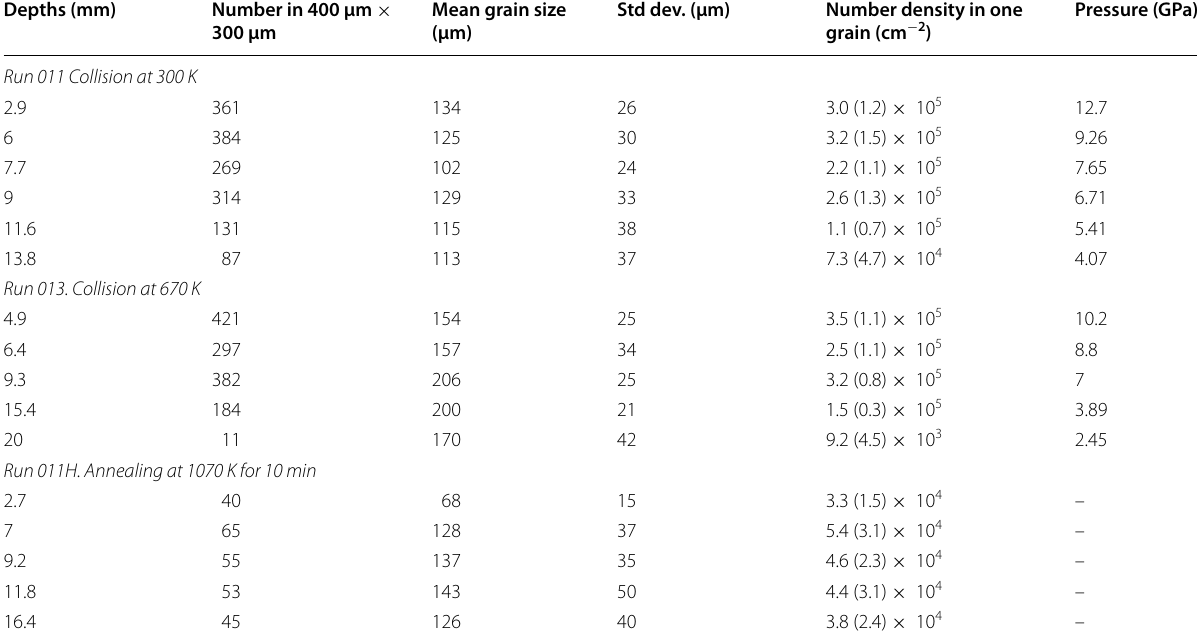
*Pressure was estimated by impact simulation (see text)